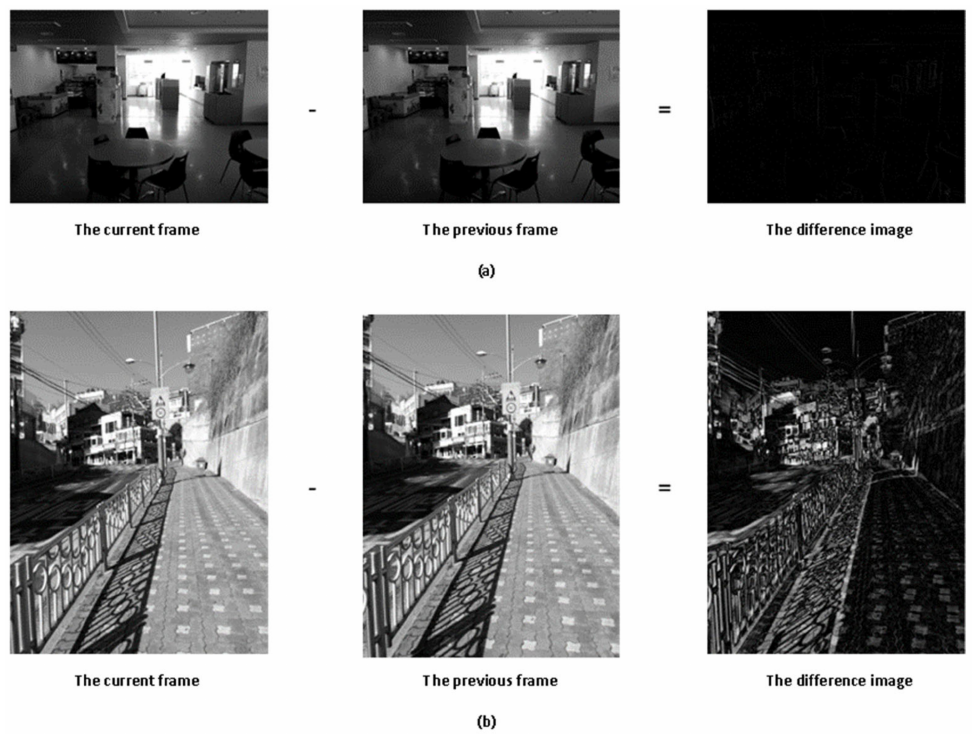
Figure 4. Detection of temporal complexity. ( a ) Example of low temporal complexity case; ( b ) Example of high temporal complexity